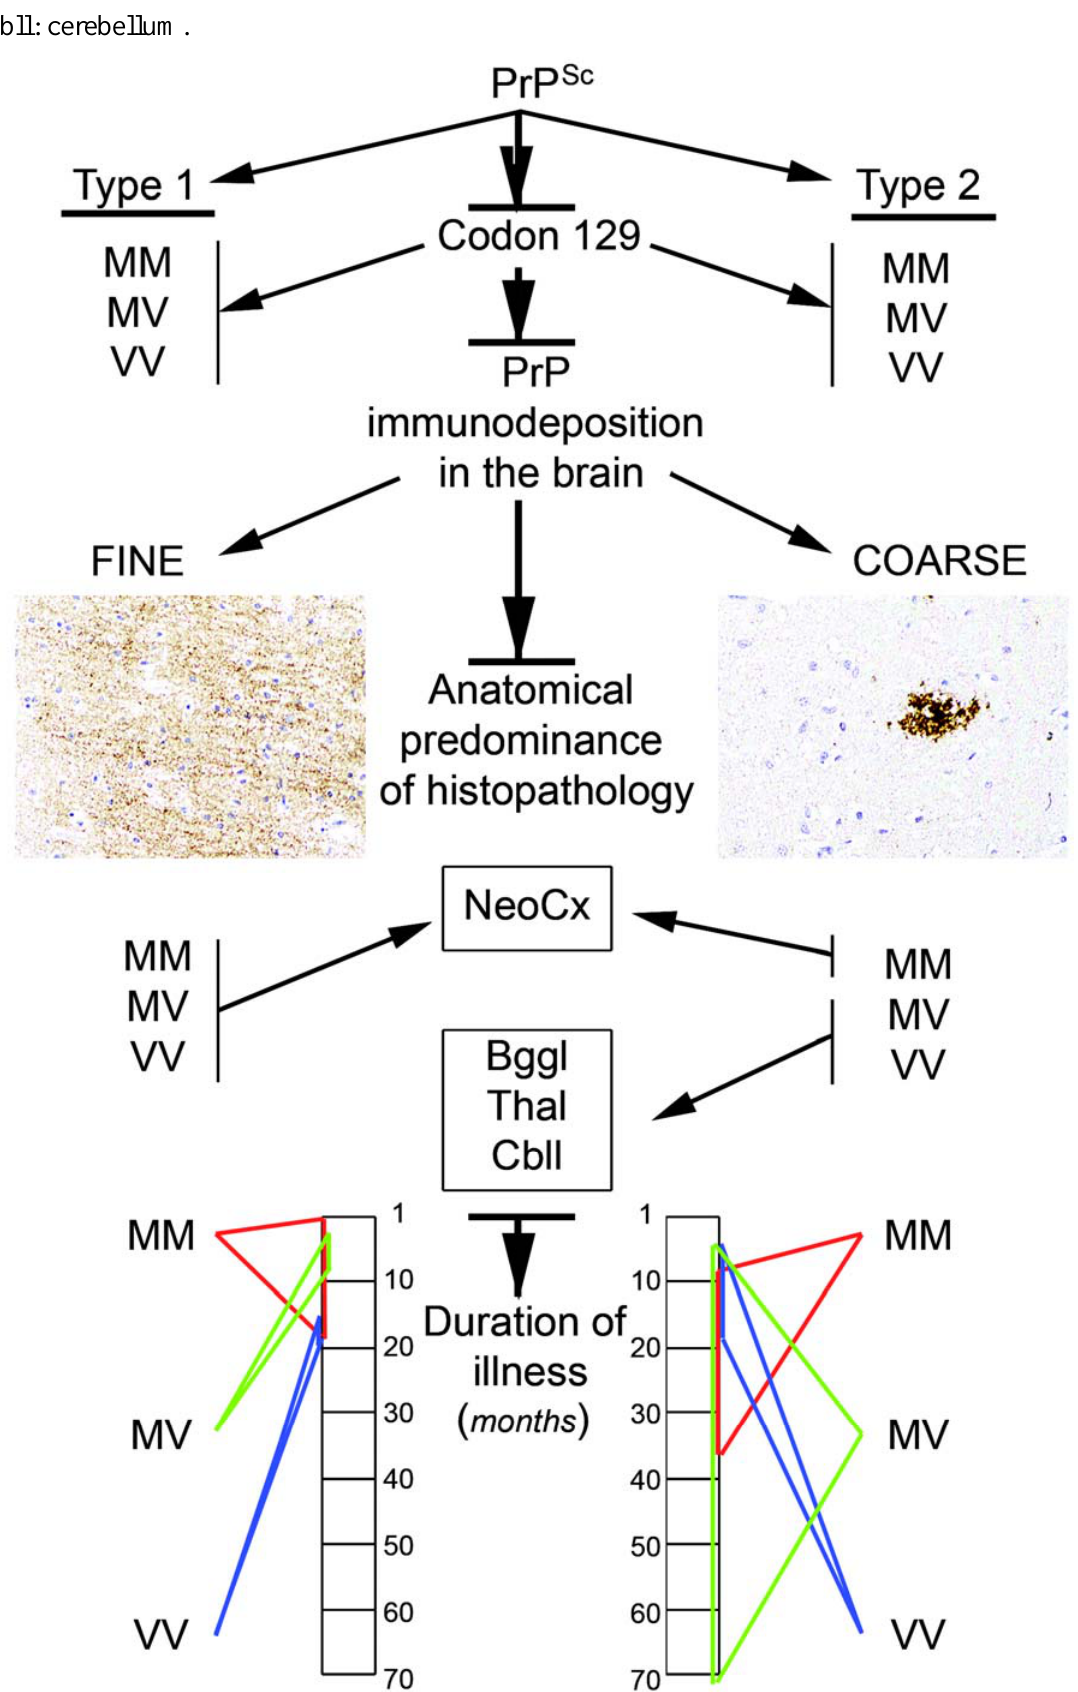
Figure 3 . Differences between molecular subtypes of sporadic Creutzfeldt-Jakob